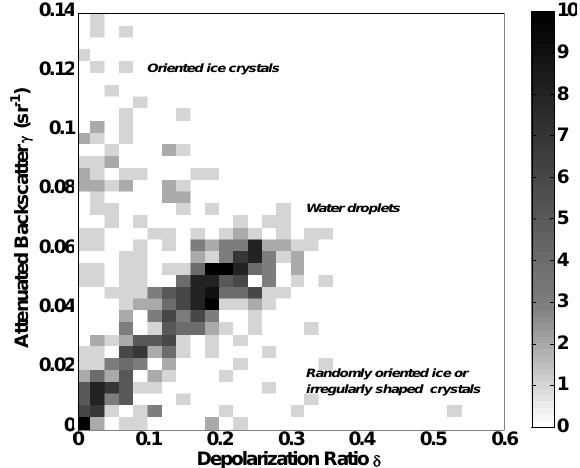
Fig. 6. CALIOP δ – γ 0 relationship obtained for measurements ob- tained on 9 April 2007. The color of each pixel represents the fre- quency of occurrence for a 1δ – 1γ 0 box with 0.02 by 0.004sr − 1 interval. The CALIOP horizontal resolution is 333m.